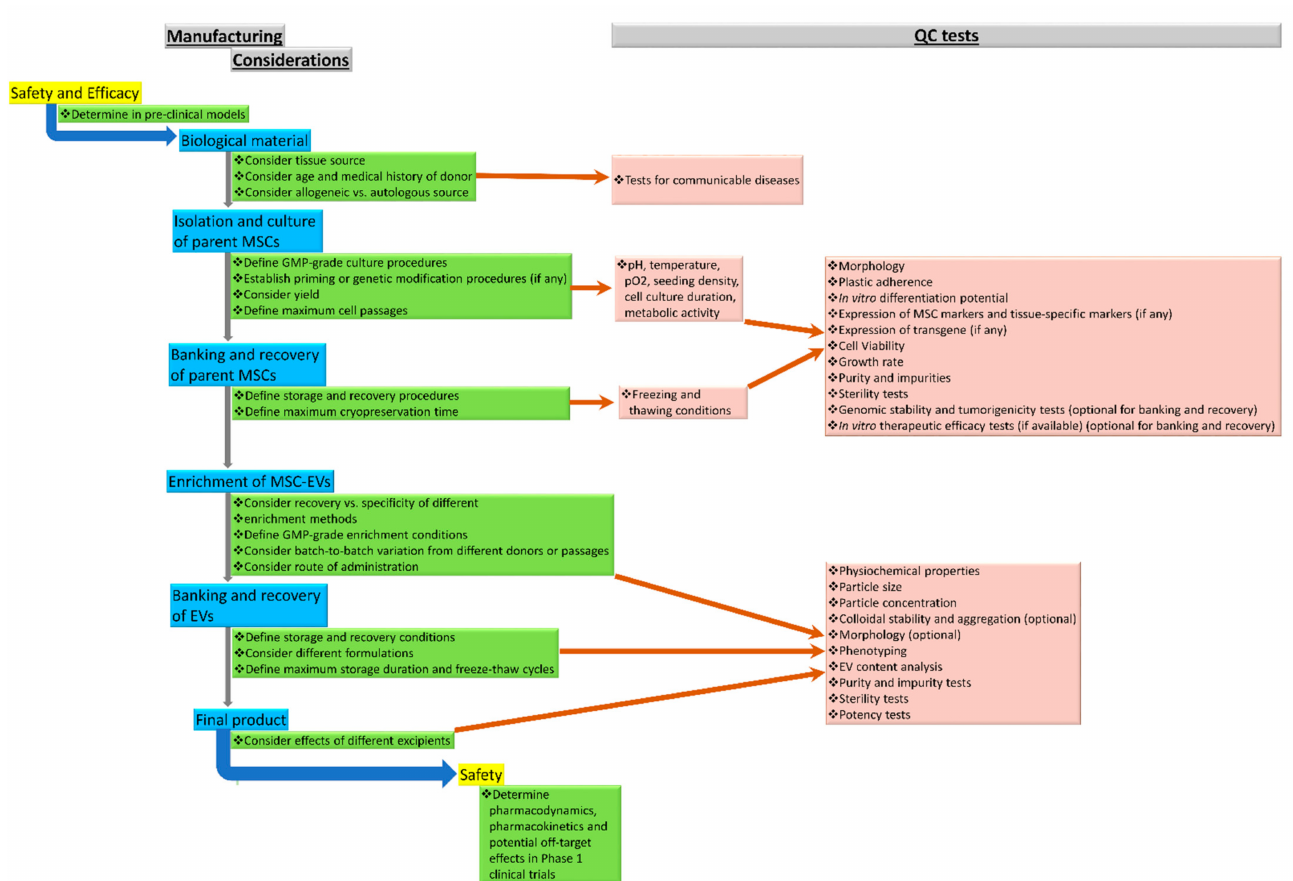
Figure 1. Manufacturing considerations and QC program for the development of GMP-grade